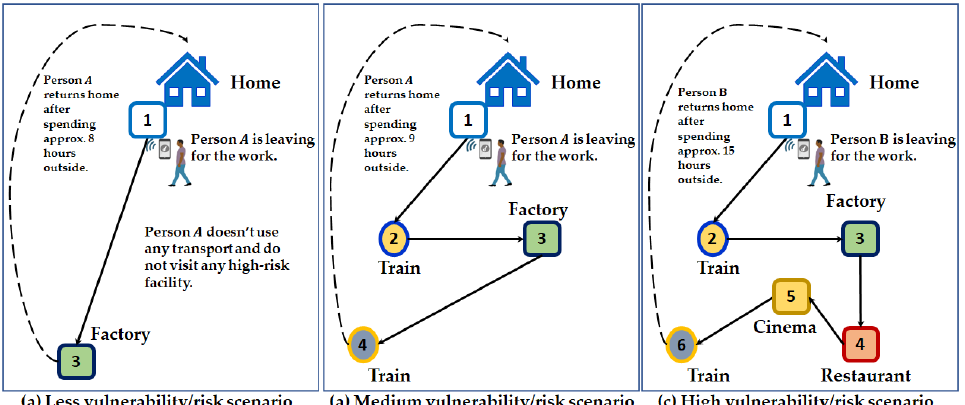
Figure 13. Overview of three vulnerability/risk scenarios based on mobility